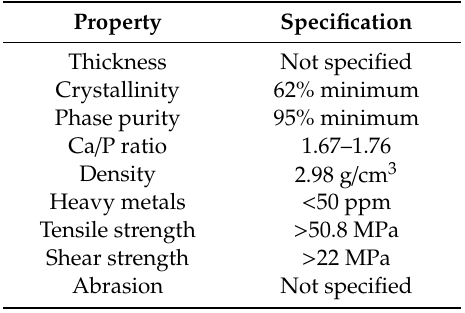
Table 1. Hydroxyapatite (HAp) coating requirements